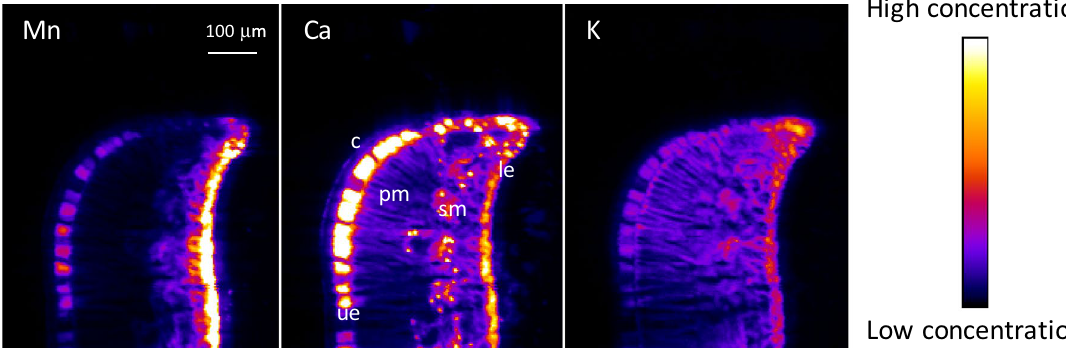
Figure 3. μXRF maps of Mn, Ca, and K for a cross-section of a frozen hydrated leaf margin of transplanted Grevillea meisneri . The pixel size is 3 μm. The intensity scales are different between elements. c cuticle, le lower epidermis, pm palisade mesophyll, sm spongy mesophyll, ue upper